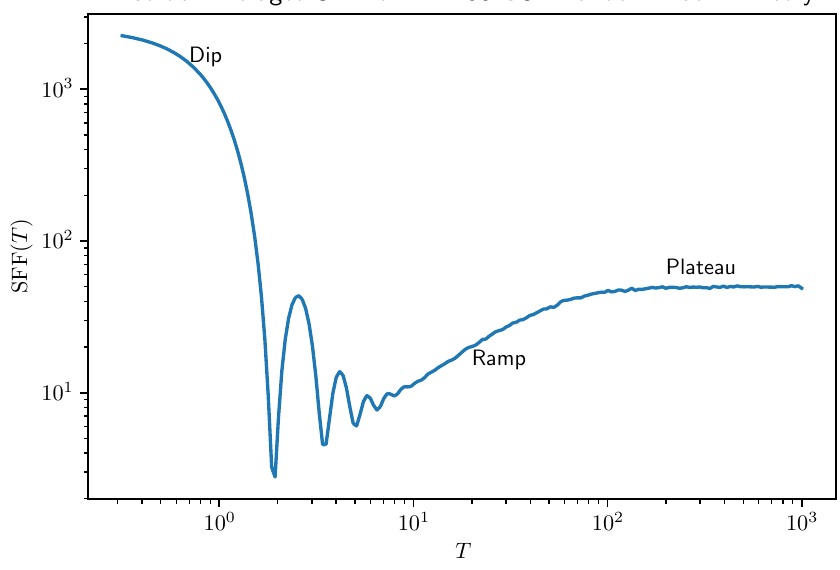
Figure 2 . The disorder-averaged SFF for the Gaussian unitary ensemble (GUE) of matrix dimension N = 50 , computed numerically by averaging over ten thousand realizations. The three distinct regimes — dip, ramp, plateau — are